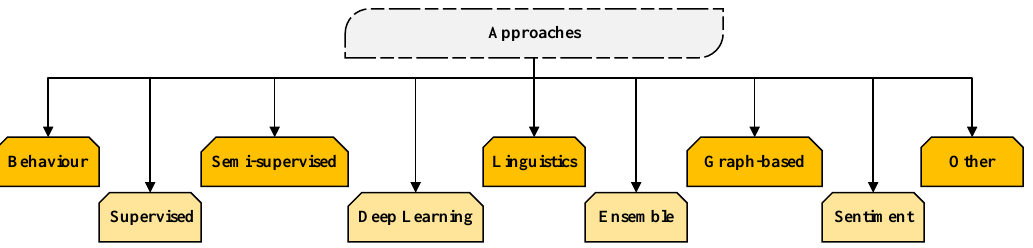
Figure 1. Type of approaches to detect spam reviews used in this